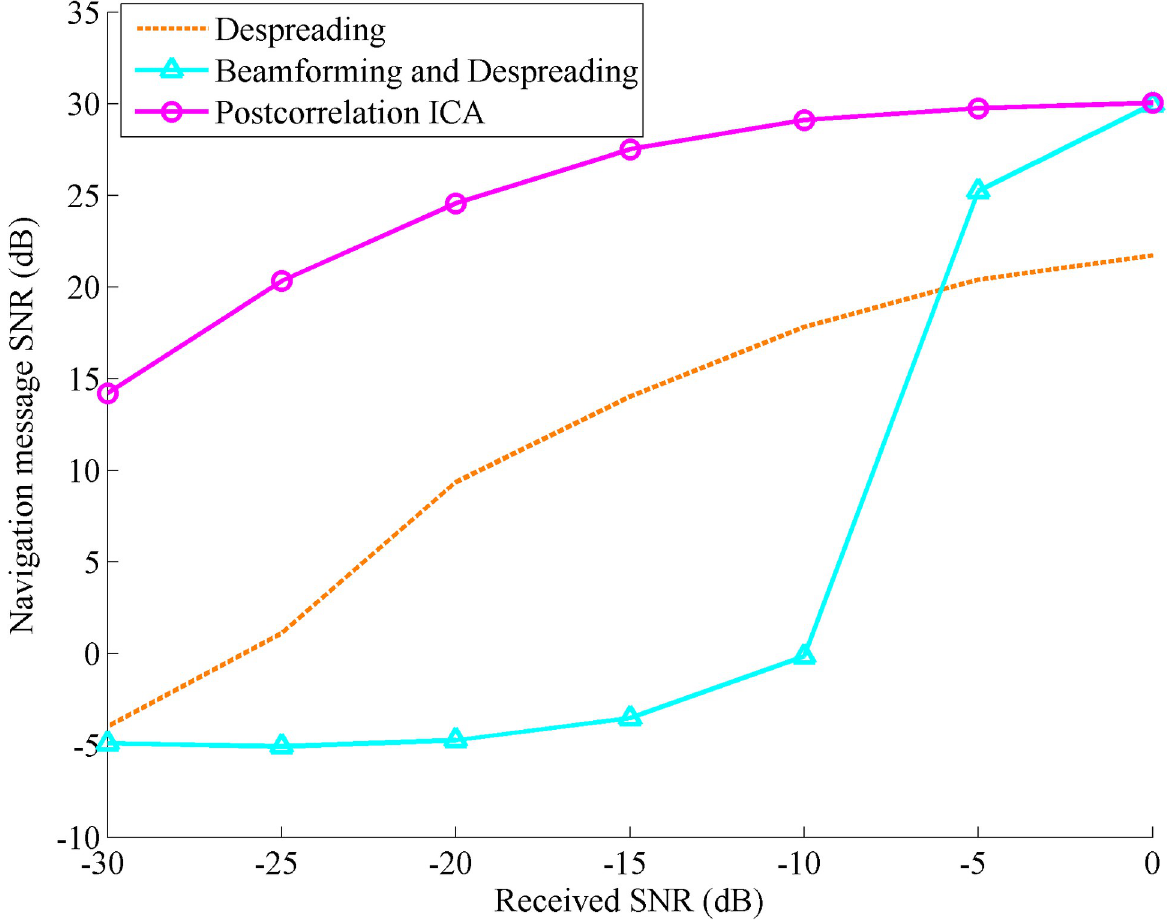
Fig 7. SNR comparison of the navigation message with the received SNR changing after despreading, beamforming and despreading, and postcorrelation ICA processing.